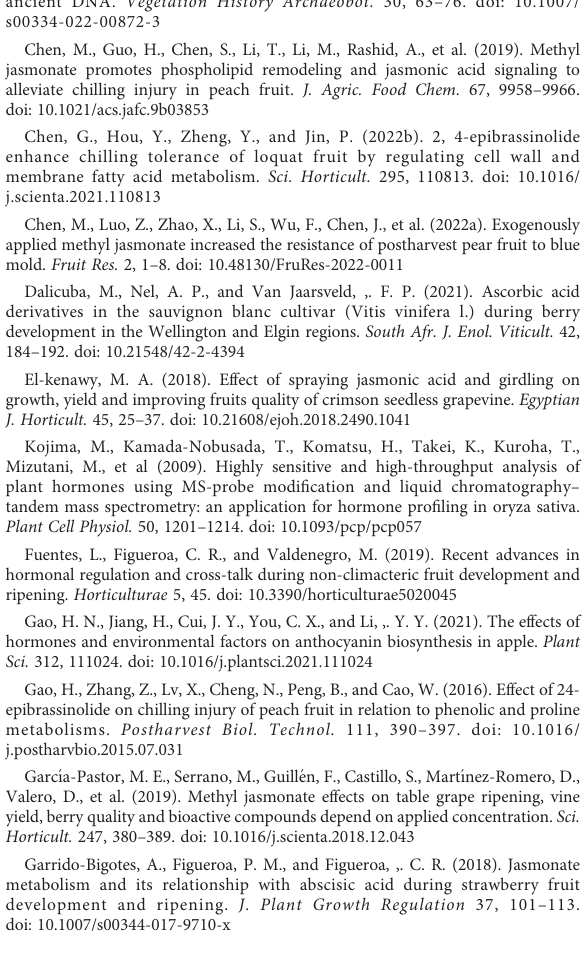
SUPPLEMENTARY FIGURE 3 Effect of exogenous EBR, JA and their signaling inhibitors on endogenous phytohormones contents in different treatment groups (Control, 0.5 mg L -1 EBR, 100 m mol L -1 JA, 0.5 mg L -1 EBR + 1 mg L -1 Brz,